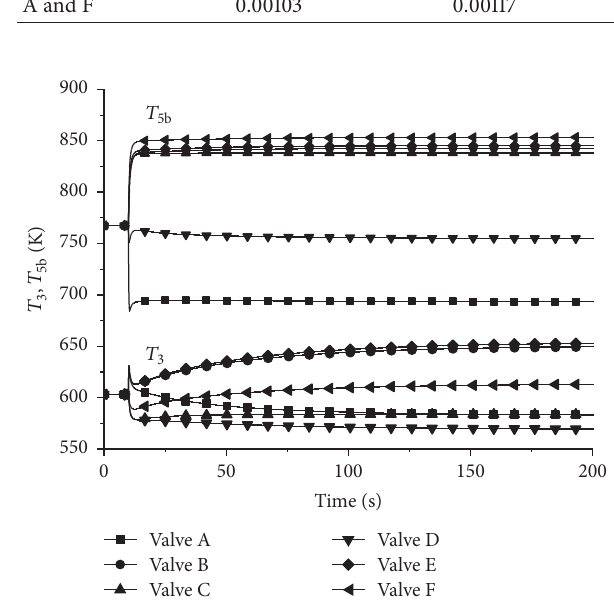
Figure 6: Gas temperature transients at reactor inlet (𝑇 3 ) and recuperator high-pressure side inlet (𝑇 5